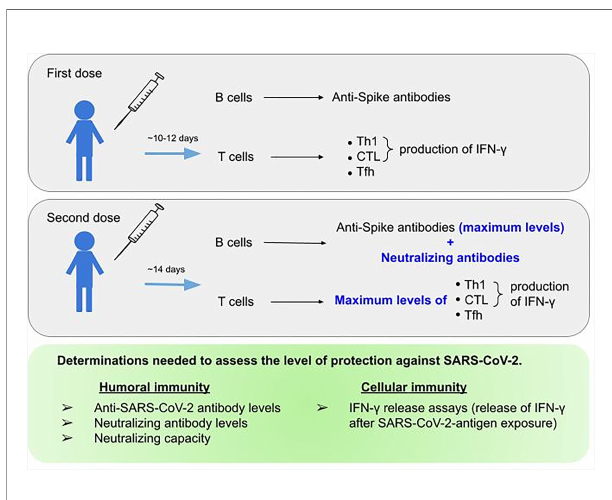
FIGURE 2 | Parameters to be assessed regarding humoral and cellular response to SARS-CoV-2 mRNA vaccine. The top and middle fi gure outline the immunological response achieved after the fi rst and second doses of mRNA vaccines, respectively. The bottom fi gure summarizes the parameters needed to assess protection against